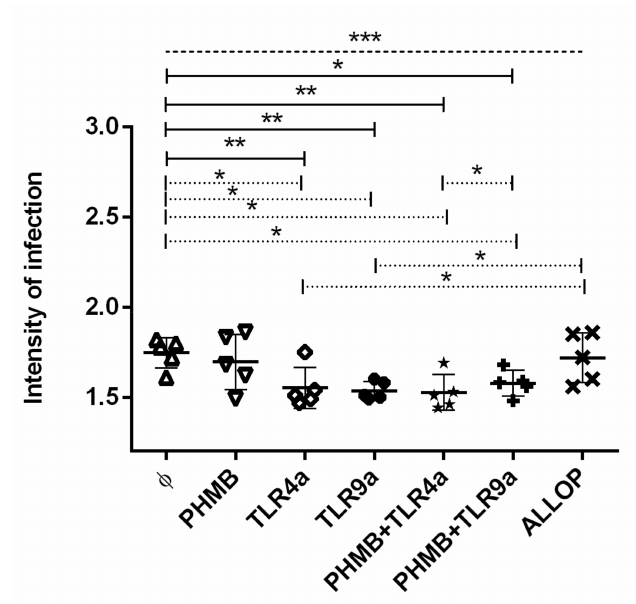
Figure 2. Intensity of in vitro L. infantum macrophage infection after 24 h treatment with the di ff erent conditions: Medium alone (Ø), Polyhexamethylene biguanide alone (PHMB), MPLA Toll-like